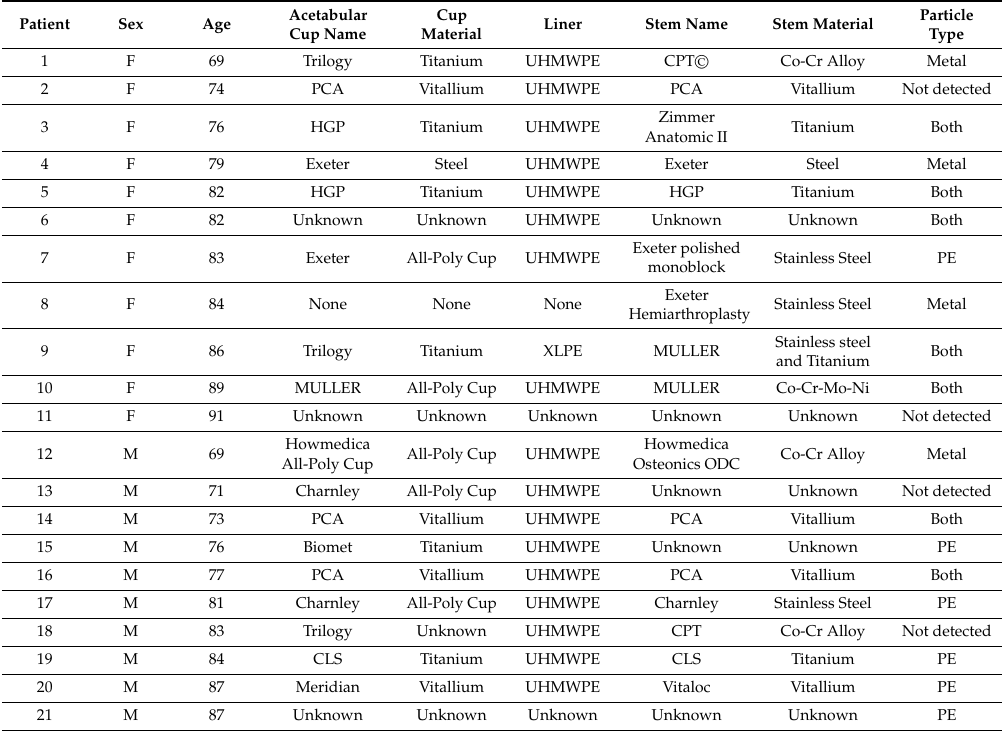
Table 2. Revision THR patient implant details. UHMWPE: Ultra-high molecular weight polyethylene; XLPE:Cross-linkedpolyethylene; CPT:collarless, polished, doubletaper; PCA:PorousCoatedAnatomic; HGP: Harris-Galante Porous; CLS: Cemented Locking